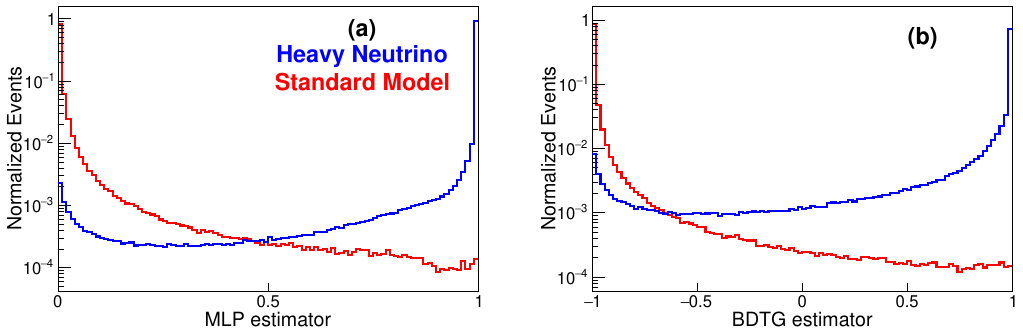
Figure 11 . ML estimator distributions of SM backgrounds (red) and heavy neutrino signal (blue) √ with m = 500 GeV at s = 14 TeV. The distributions are normalised so that tyheir integrals are N equal to 1. The left and right panels are for the MLP and BDTG methods,